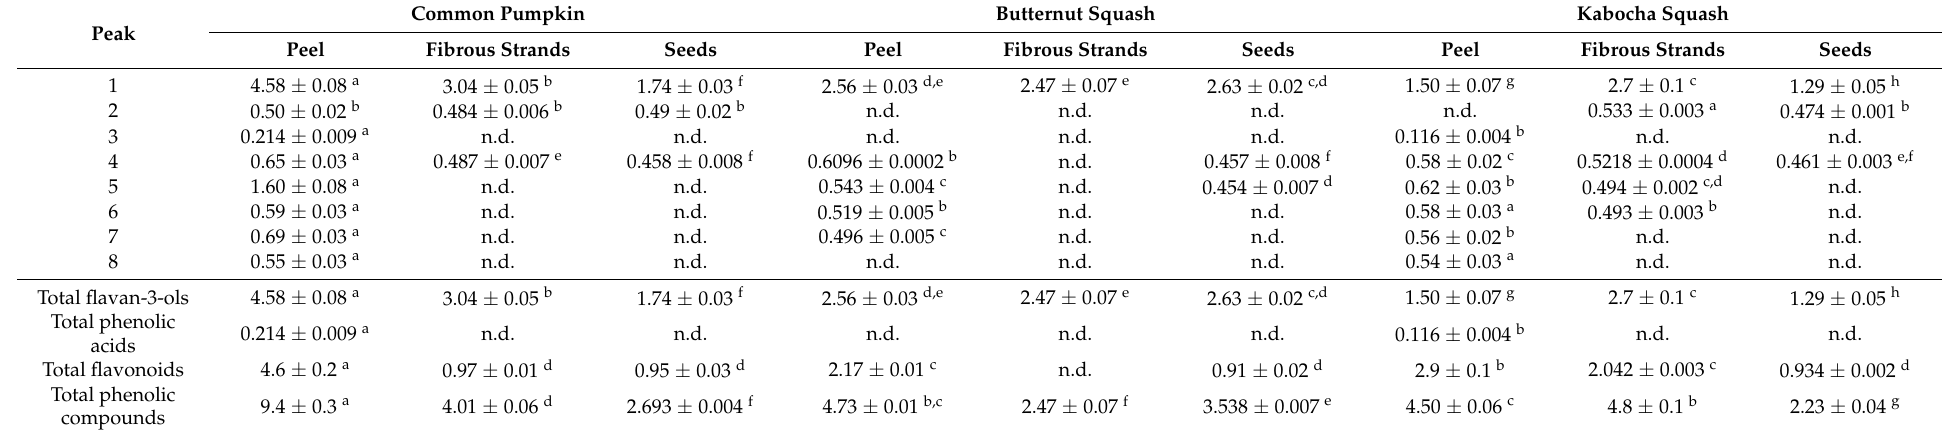
n.d.—not detected. Calibration curves used for quantification: (-)-catequin ( y = 84,950 x − 23,200, R 2 = 0.999, LOD = 0.17 µ g/mL; LOQ = 0.68 µ g/mL, peak 1); p -hydroxybenzoic acid ( y = 208,604 x + 173056, R 2 = 0.9995, LOD = 1.37 µ g/mL; LOQ = 4.15 µ g/mL, peak 3); and quercetin 3- O -glucoside ( y = 34,843 x − 160,173; R 2 = 0.9998; LOD = 0.21 µ g/mL; LOQ = 0.71 µ g/mL, peaks 2, 4, 5, 6, 7 and 8). ANOVA analysis—In each row different letters mean significant differences ( p <